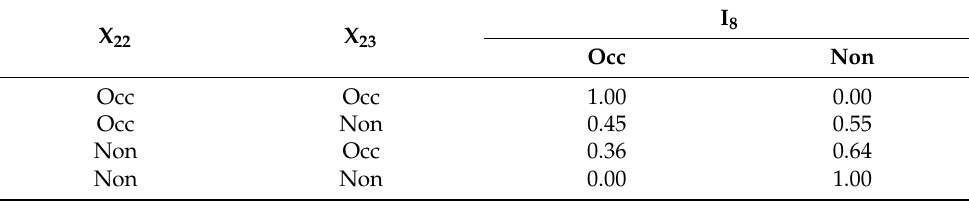
Table A7. The CPT of event I 8 (External corrosion; Occ: occurred; Non: non-occurred). X 22